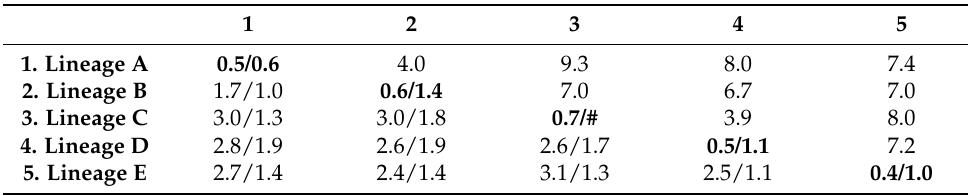
Figure 1. ( A ). Phylogenetic relationships, species delimitation hypotheses and geographical distribution of the Dendropsophus nanus–Dendropsophus walfordi species complex. The cladogram shows the strict consensus of the 6 most parsimonious trees (with 1397 steps) inferred by TNT from Matrix 1. The terminals are identified by their specimen voucher number (see Table S1) and locality. The outgroup is not shown. Bootstrap values greater than 50% are shown at the nodes. Asterisks indicate a bootstrap value of 100%. The delimitation of independently evolving lineages inferred by the tree-based method (bPTP), the distance-based method (ABGD) and the call and morphology analyses are represented by colored bars. ( B ). Geographical distribution of the genetic lineages shown in A. The lineages are identified by the same colors used in the cladogram. Star: type locality of D. nanus . Triangle: type locality of D. walfordi. Square: type locality of D. minimus . Black dots in the map represent sites sampled only for morphological or acoustic analyses. Circled dots in the map indicate sites included in the genetic analyses based on the 16Sar-16Sbr fragment but not in the phylogenetic analyses (see text for details). ( C ). Divergence time estimates for the Dendropsophus nanus – Dendropsophus walfordi species complex. The bars on the nodes indicate 95% highest posterior density (95% HPD) intervals. The corresponding timescale is shown below the cladogram. Mya: million years ago. Table 1. Uncorrected p-distances (%) between Lineages A–E of the D. nanus – D. walfordi species complex. In the lower triangle, values estimated from H1 fragments (2472 bp) (left) and from the 16Sar-16Sbr fragment of the 16S rRNA gene (right); in the upper triangle, values inferred from the COI fragment (645 bp). The diagonal line (in bold) presents uncorrected p-distances identified within each species or lineage based on the H1 (left) and COI (right) fragments. The hash mark denotes that only one sequence is